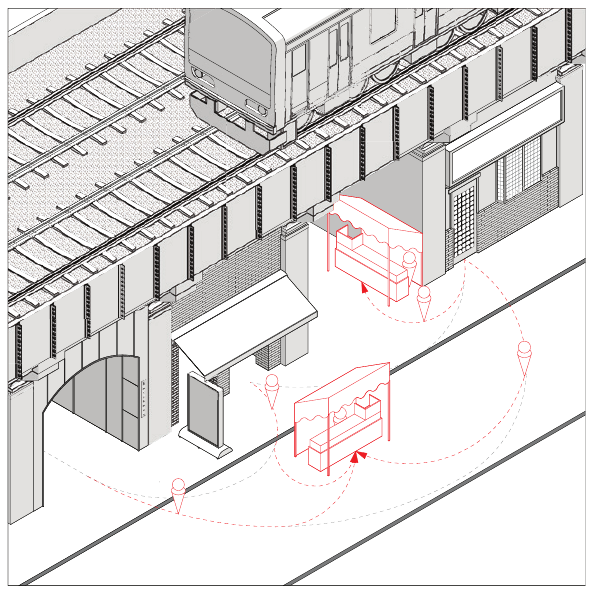
Figure 4. ‘Hyper transient parasite’ feeds of off the development of movement between the original host and the ‘destination